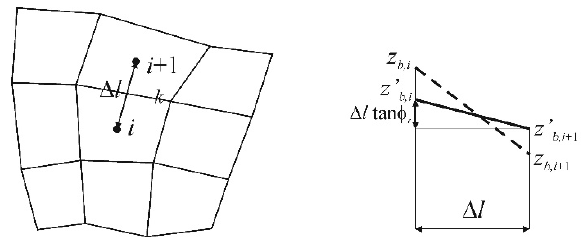
Figure 3. The avalanching algorithm.